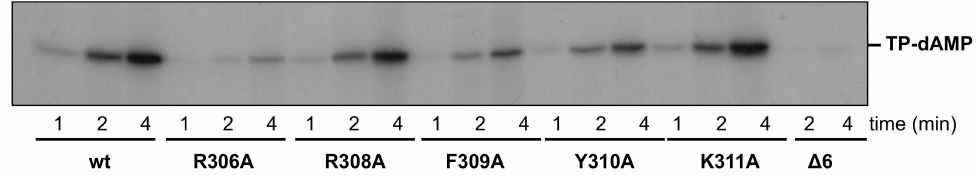
Figure 6. In vitro protein-primed initiation. The initiation reaction was performed as described in Materials and Methods, using as template Phi29 TP-DNA. After incubation for at the indicated times at 30 ◦ C, the reaction was stopped, processed, and analyzed by dodecyl sulfate sodium-polyacrylamide gel electrophoresis (SDS-PAGE) and autoradiography. The position of the terminal protein-deoxyadenosine monophosphate (TP-dAMP) complex is